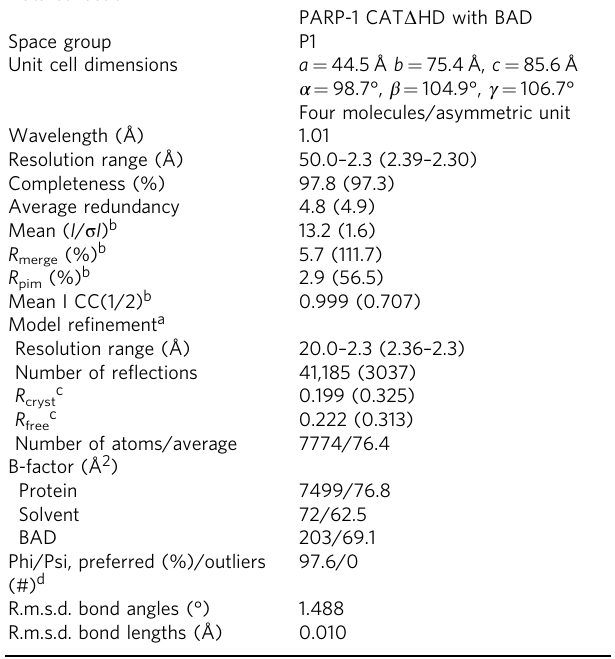
Table 1 Crystallographic data and re fi nement statistics Data collection a Space